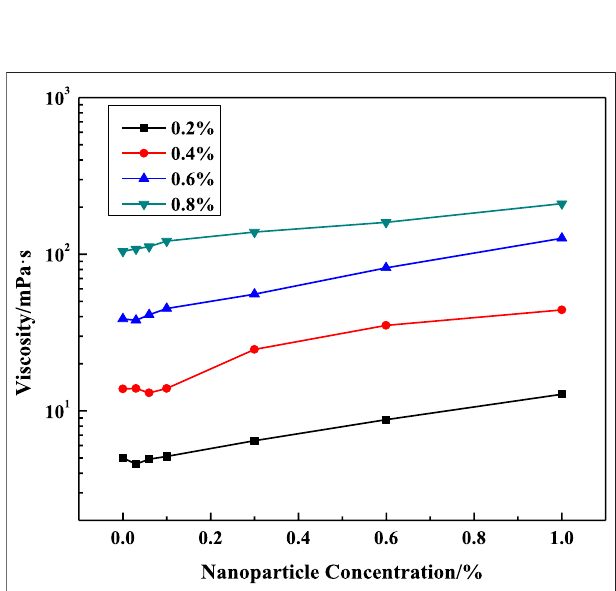
FIGURE 7 | Effect ofSiO 2 concentration on solution viscosity at different salinities ( w (LBA + SDS) (cid:2) 0.8%, LBA:SDS (cid:2) 3:1, T (cid:2) 50 ° C, γ (cid:2) 7.34s − 1 ).